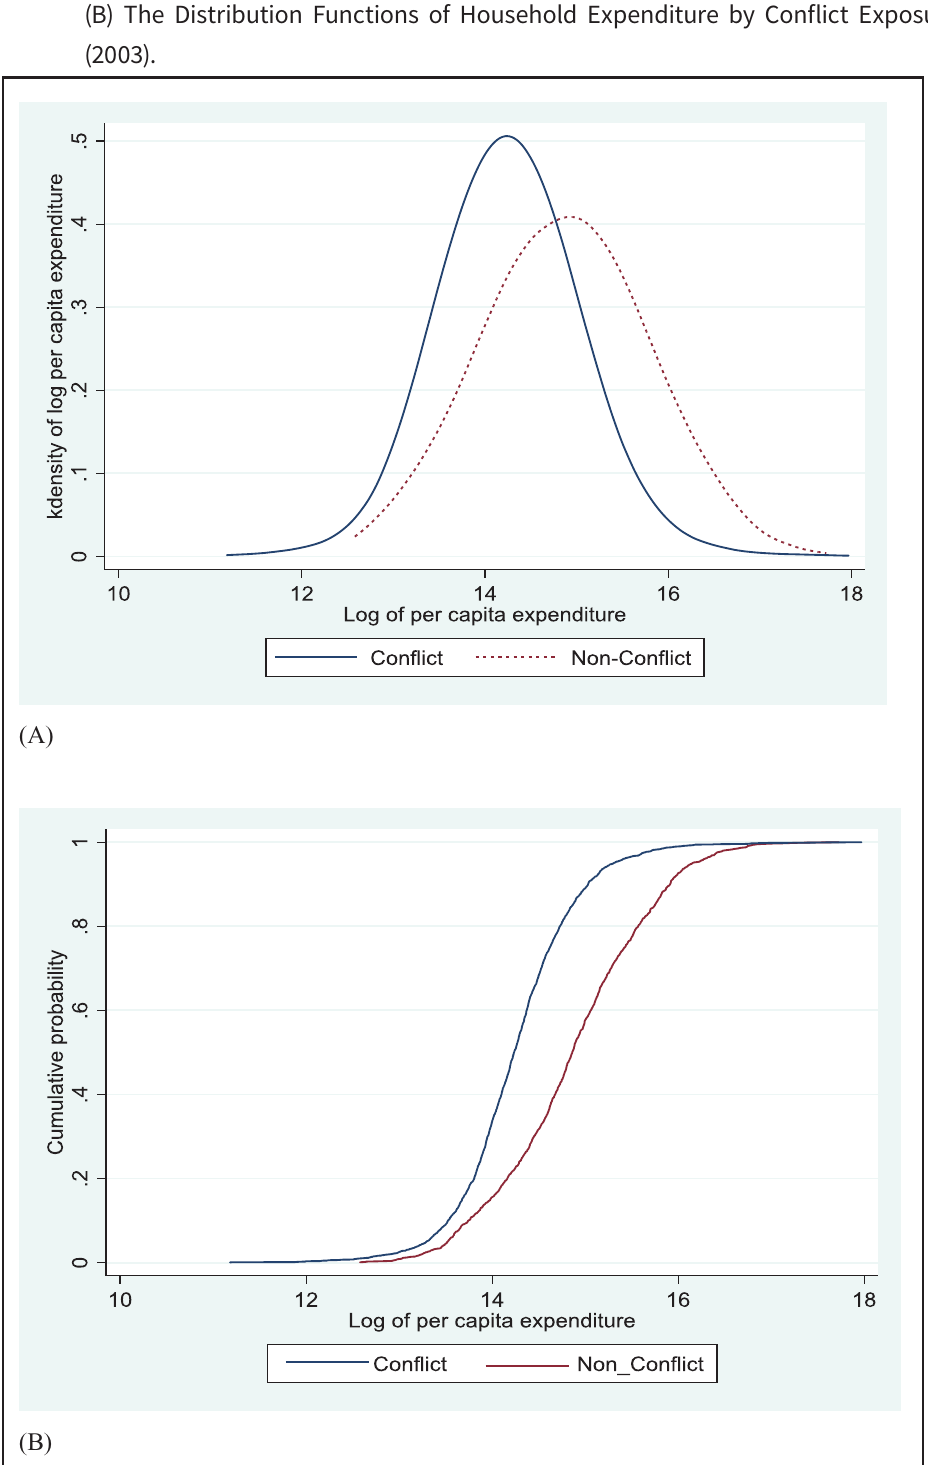
between the conflict and non-conflict zones. In contrast, the density plot for the non-conflict areas in 2003 (see Figure 2A) exhibits a locational shift to the right compared to the corre- sponding plot for the conflict zones with evidence of narrowing dispersion within these zones. A similar pattern emerges for the density plots for the most recent year of 2011, though the impact on expenditure inequality appears less clear-cut (see Figure (A) The Density Functions of Household Expenditure by Conflict Exposure (2003). (B) The Distribution Functions of Household Expenditure by Conflict Exposure (2003).